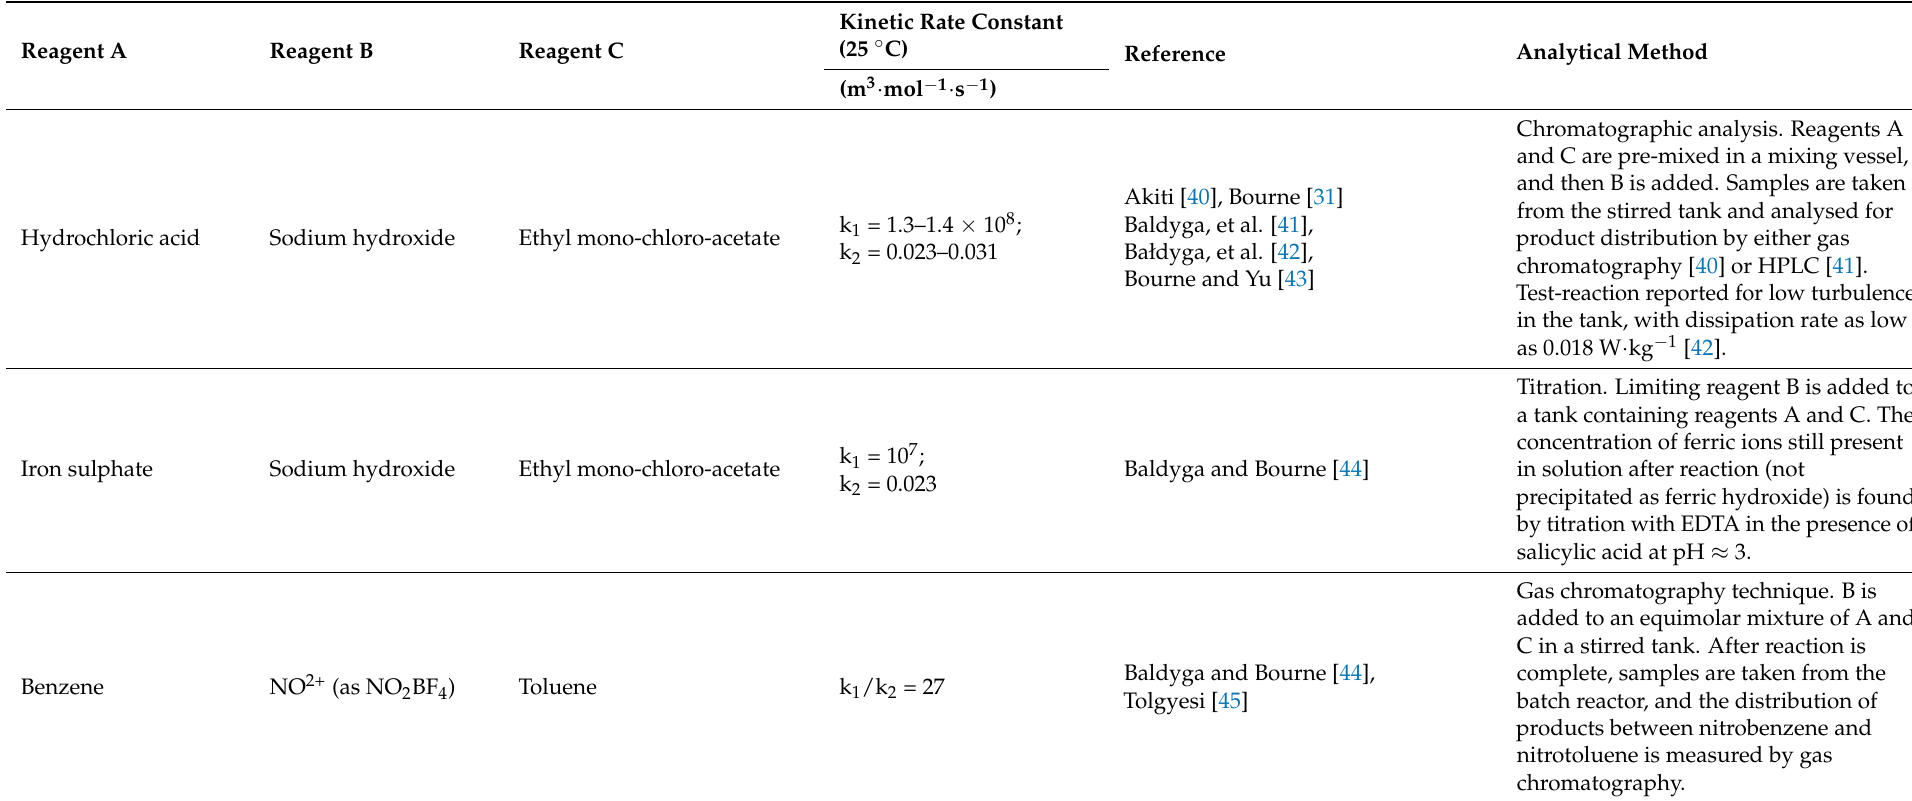
Table 2. Operational parameters for several chemical methods for assessing micromixing based on competitive-parallel reactions: A + B → R; C + B →